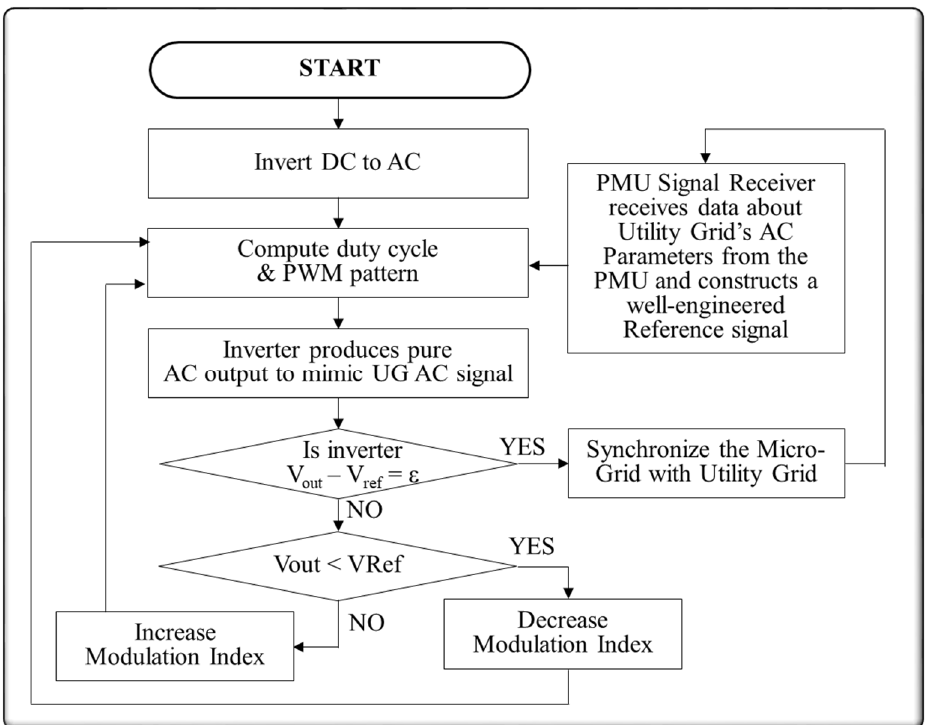
Figure 2. Inverter Output Wave Shaping and Synchronization Process.